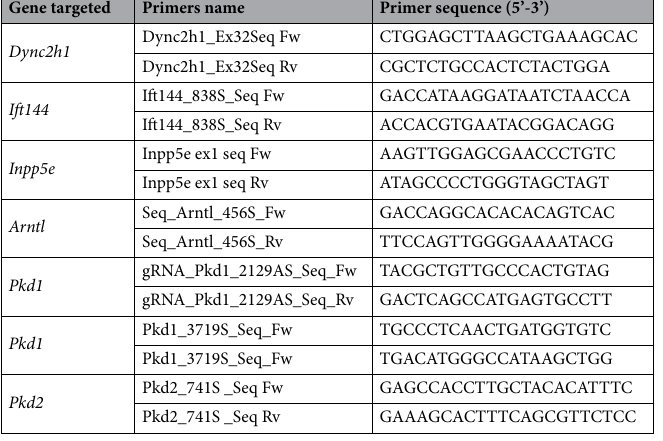
Table 2. Sequencing